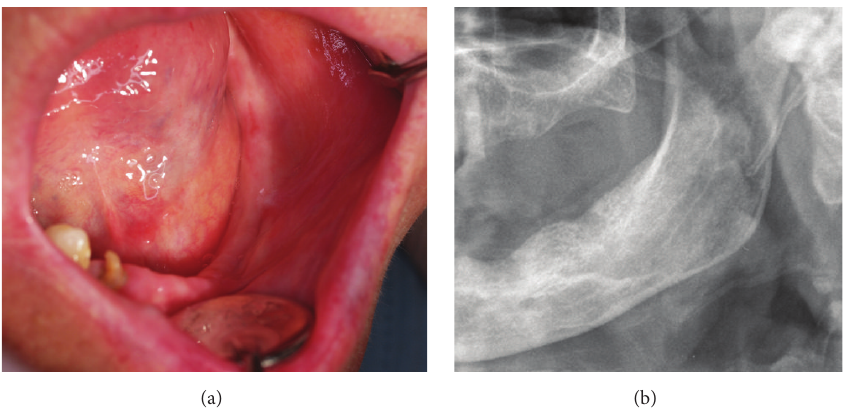
Figure 5: Clinical and radiographic appearance one year after excision of the lesion without signs of recurrence ((a) intraoral view and (b) panoramic radiographic